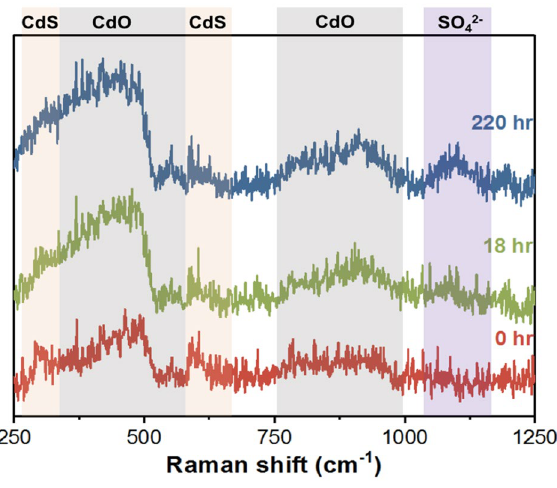
Figure 8. Raman spectra of QDs vs. test time tested under ambient condition.